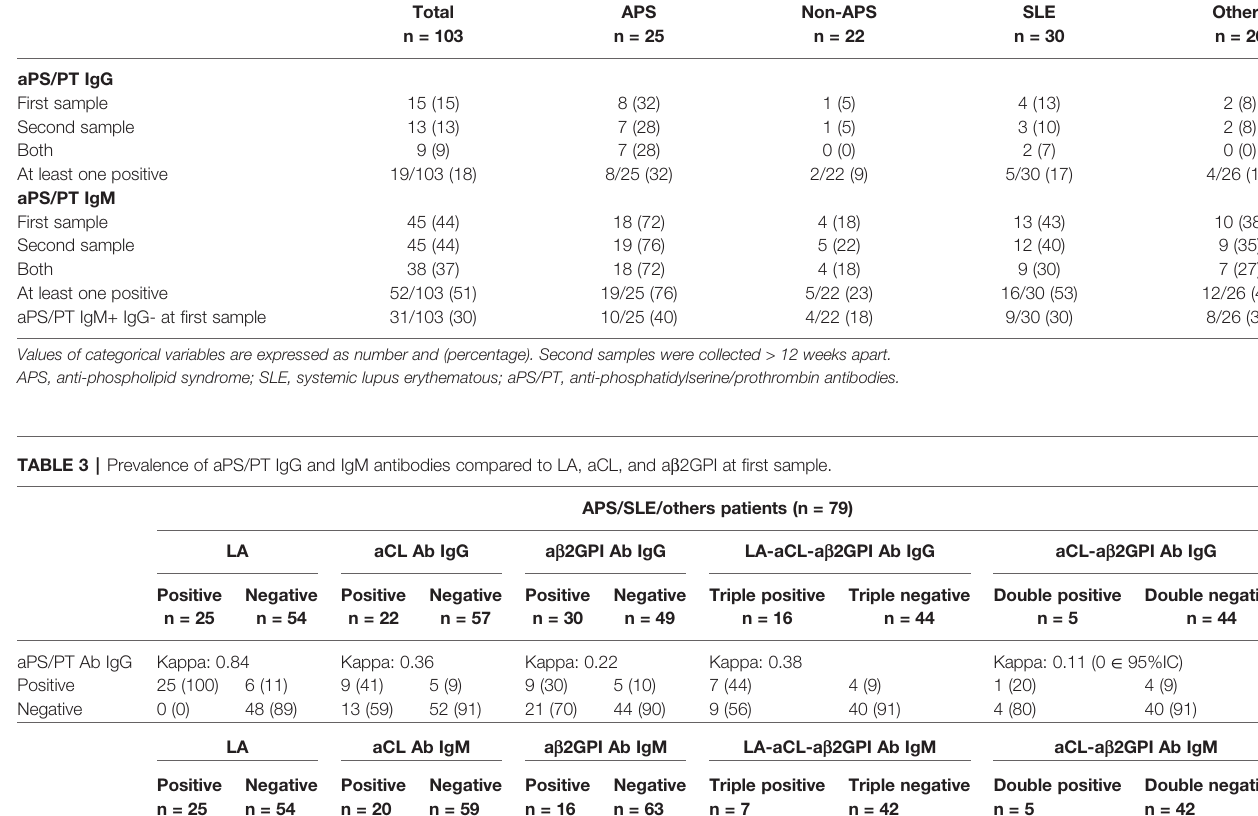
( Table 2 ). Similar fi ndings (non- fl uctuating aPS/PT Ab results) were seen with second serum samples from a follow-up blood draw separated by >12 weeks. Persistent positivity rates for aPS/ PT IgG and IgM Ab were 28% and 72% for APS, 0% and 18% for non-APS, 7% and 30% for SLE, and 0% and around 30% for Others, respectively. Prevalence of aPS/PT IgG and IgM antibodies compared to LA, aCL, and a b 2GPI at fi rst sample were also analyzed ( Table 3 ). The best agreement was obtained between the aPS/PT IgG Ab and LA (Cohen kappa: 0.84). Due to the better results obtained for IgG aPS/PT Ab (speci fi city 84%) versus IgM (speci fi city 50%), we decided to more extensively analyze the IgG isotype. Overall, 19 (18.4%) patients were positive for aPS/PT IgG Ab, at either one (n = 10) or both (n = 9) sample points. Patients with at least one sample positive for aPS/PT IgG were 8/19 APS, 2/19 non-APS, 5/19 SLE, and 4/19 Others. The correlation of aPS/PT IgG Ab levels between the fi rst and second samples for those 19 patients was calculated and showed a Spearman ’ s ratio of 0.72 (95% CI 0.38 – 0.89).